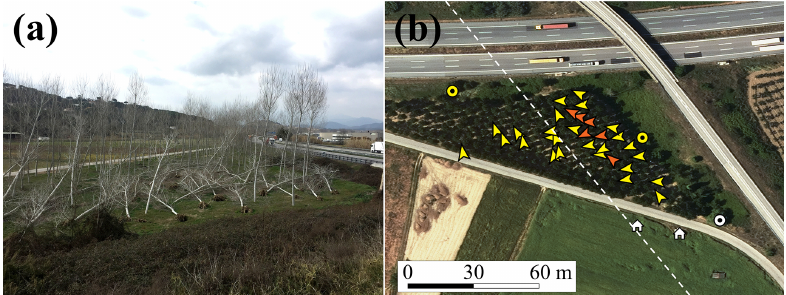
Figure A2. (a) A poplar plantation from Fogars de la Selva (Catalonia) affected by the 15 October 2018 EF1 Malgrat de Mar–Massanes tornado, and (b) fallen-tree directions of the same poplar plantation. Map symbols indicate locations of damage in human-made structures (house icon) and fallen tree or damaged vegetation elements (arrow or circle icon if no direction is available). Icon colours indicate damage intensity: EF0 (yellow), EF1 (orange) and unrated (white). The white discontinuous line separates the right-hand and the left-hand sides of the damage swath where predominant tree fall directions are west and north, respectively. The background orthophoto is from the Institut Cartogràfic i Geològic de Catalunya (ICGC), http://www.icc.cat, under a CC BY 4.0